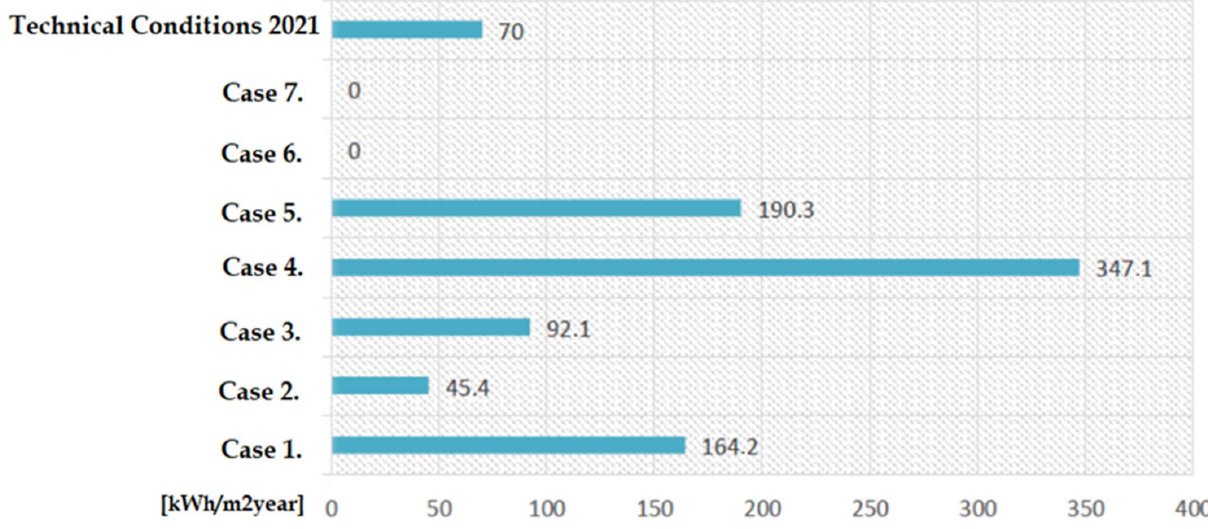
Figure 3. A collective summary of the results of the demand of the analyzed variants for EP in relation to the EP value established by the Technical Conditions for 2021 (own elaboration).